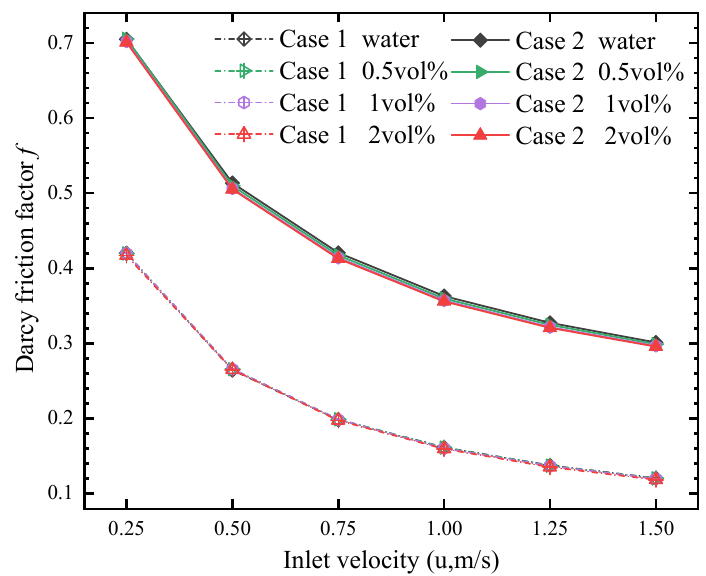
Figure 11. Darcy friction factor f at different inlet velocities and volume fractions.